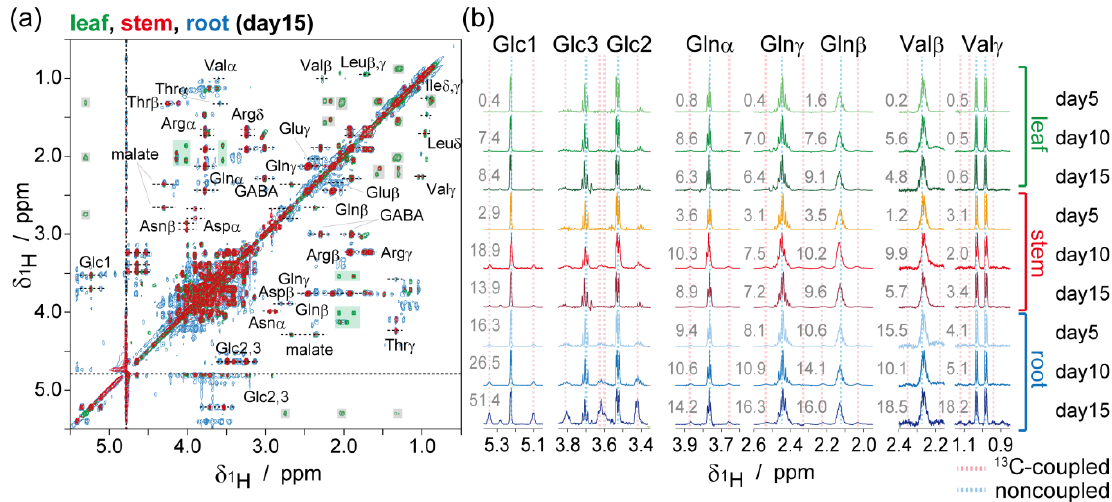
Figure 4b. Estimated 13 C-enrichments of glucose C1 in root at 5, 10, and 15 days after seeding were 16.3%, 26.5%, and 51.4%, respectively. Additionally, estimated 13 C-enrichments of glucose C1 in stem at 5, 10, and 15 days after seeding were 2.9%, 18.9%, and 13.9%, respectively. And estimated 13 C-enrichments of glucose C1 in leaf at 5, 10, and 15 days after seeding were 0.4%, 7.4%, and 8.4%, respectively. This trend is the same as total 13 C-enrichments measured with IR-MS, indicating that most glucose assimilated by the root was